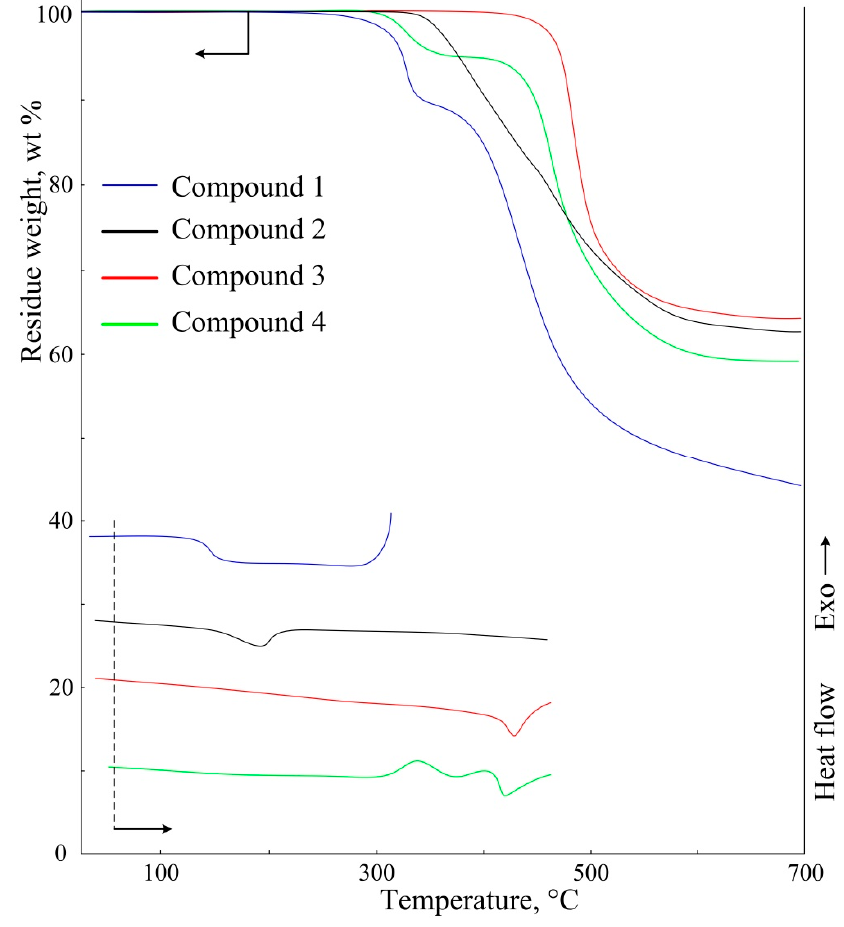
Figure 3. TGA and DSC curves of the obtained compounds.